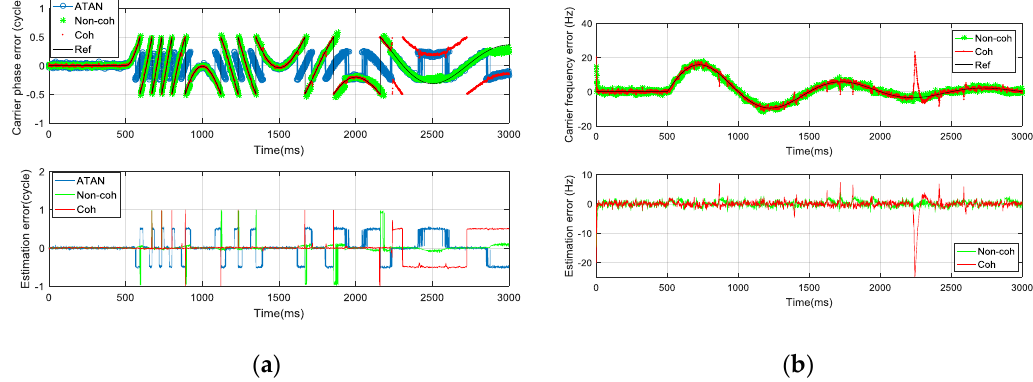
Figure 13. ( a ) The carrier phase error estimation in test scene C; ( b ) The carrier frequency error